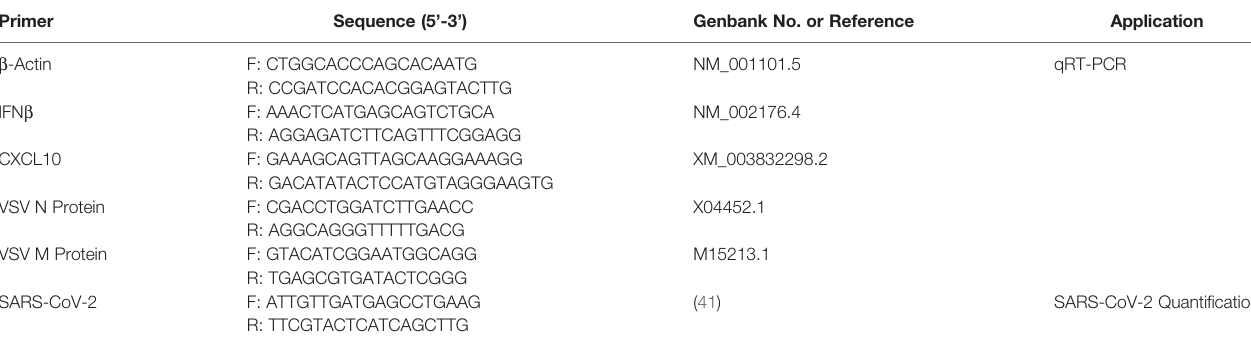
TABLE 2 | Primers used for qRT-PCR analyses and for SARS-CoV-2 qPCR quanti fi